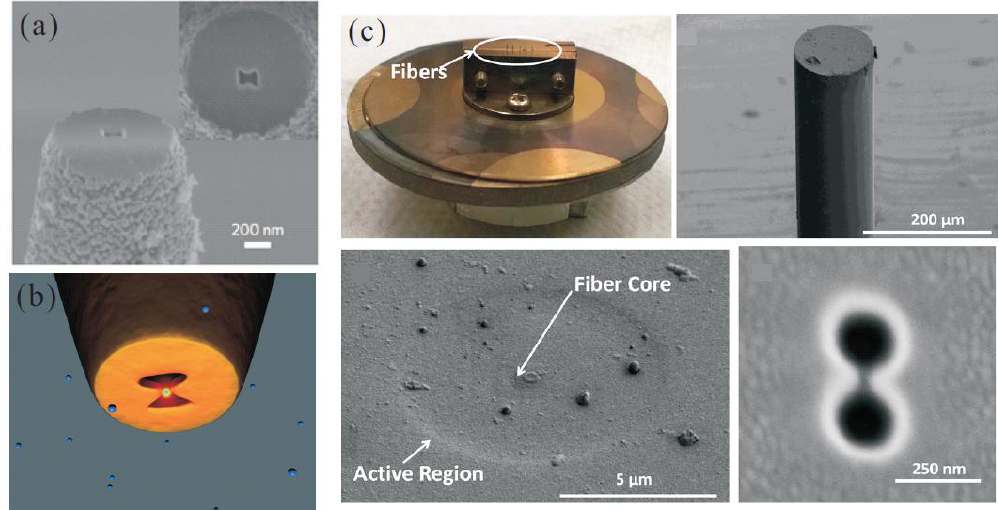
Figure 15. ( a ) SEM image of an 85-nm-gap bowtie nano-aperture (BNA) patterned at the extremity of a tapered optical fiber; ( b ) Schematic of experimental configuration for trapping nano-particle [214]; and ( c ) double nanohole in a cleaved optical fiber end [218]. ( c ) double nanohole in a cleaved optical fiber end